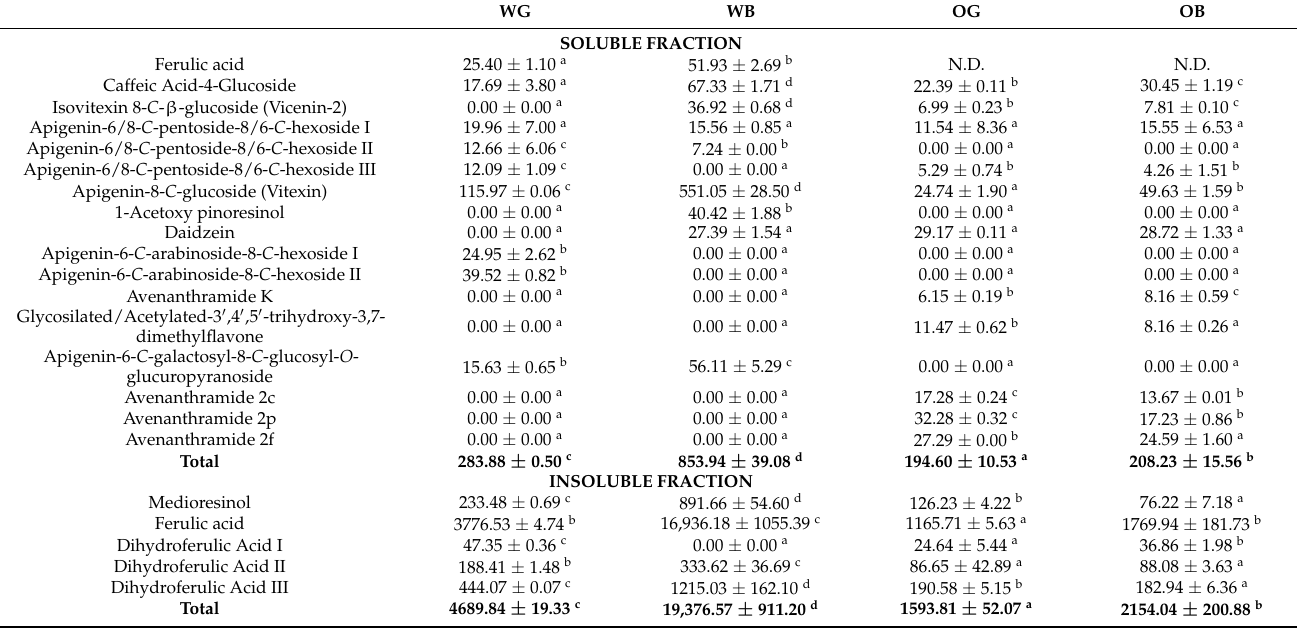
Table 2. HPLC-DAD-ESI/MS analysis of free (FP) and bound (BP) phenolic fractions of wheat grain (WG), oat grain (OG), wheat bran (WB) and oat bran (OB). Results were expressed in ( μ g g − 1 d.m.).